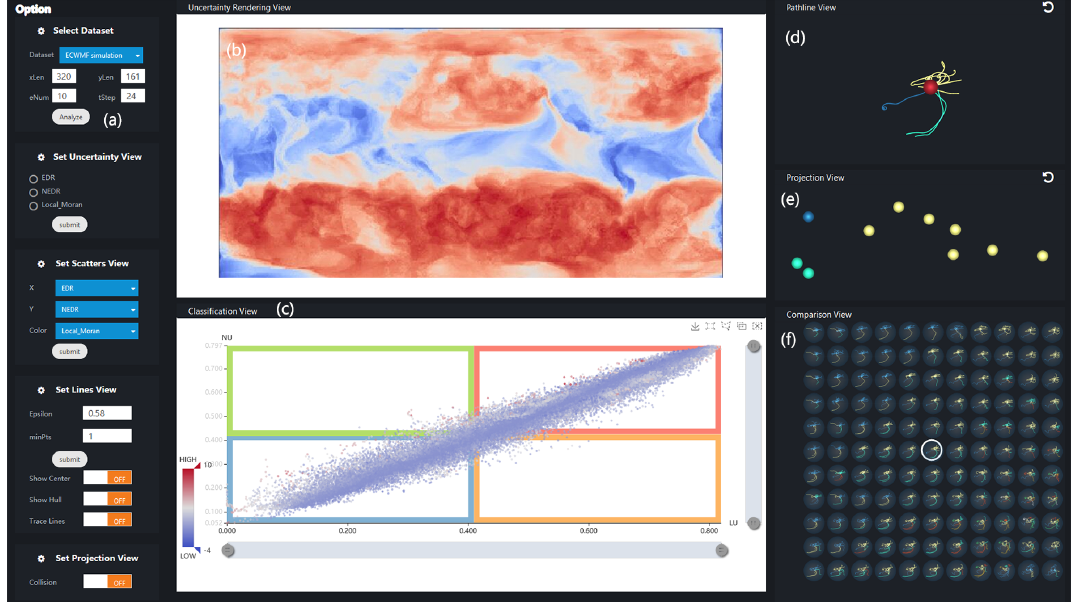
Figure 5. Interfaces of UP-Vis: ( a ) Parameter panel, ( b ) uncertainty rendering view, ( c ) classification view, ( d ) pathline view, ( e ) projection view, and ( f ) comparison